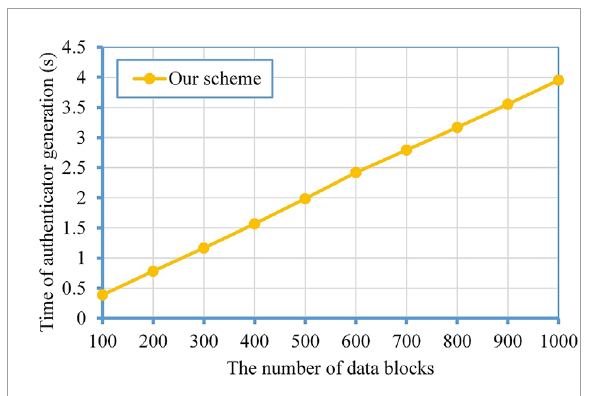
FIGURE 2 The computation overhead of authenticator generation.